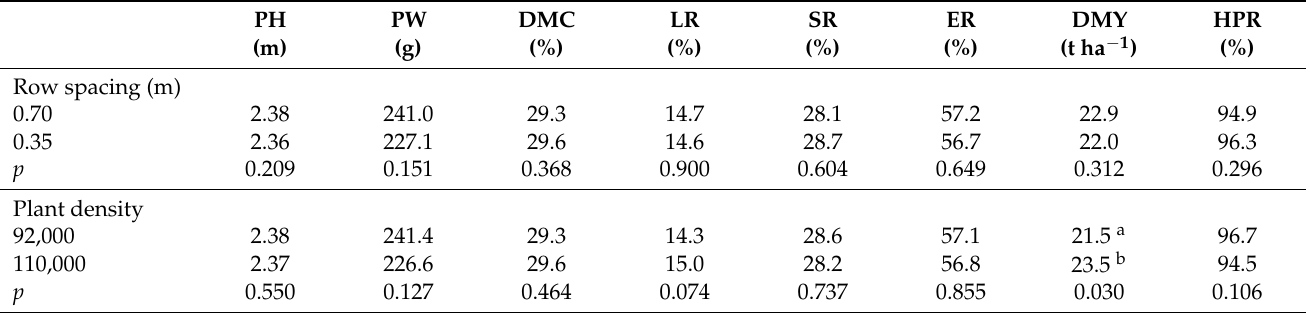
Table 6. Plant height (PH), plant weight (PW), dry matter content (DMC), leaf ratio (LR), stalk ratio (SR), ear ratio (ER), dry matter yield (DMY) and harvested plant ratio (HPR) for two row